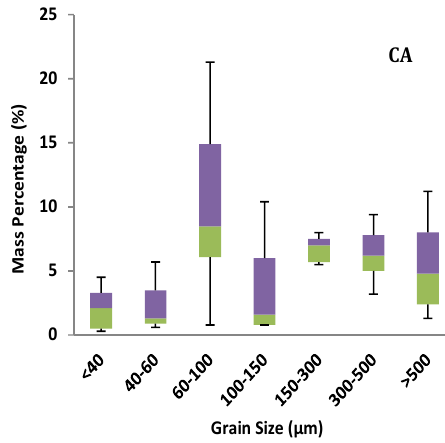
Figure 6. Box plots of the mass percentages of RDS particles in each grain size. The transport factors investigated in this research were chosen primarily for their ability to alter surface runoff, which in turn affects the RDS index. The transport variables in the RDS index were represented by the proportion of each RDS particle size washed off the surface (Fwi), and the Fwi observed values ranged from 0.99% to 77.21%. Using the Fwi observed values, the amount of wash-off was determined for each of the RDS size fractions by changing the quantities and particle size compositions in the RDS to correspond to those in the sampling areas [24]. Figure 7 illustrates the RDS wash-off quantities along the functional areas. Increases in rainfall intensity increased the number of particles washed off per unit area, but wash-off as a percentage of RDS was reduced throughout all the functional areas.